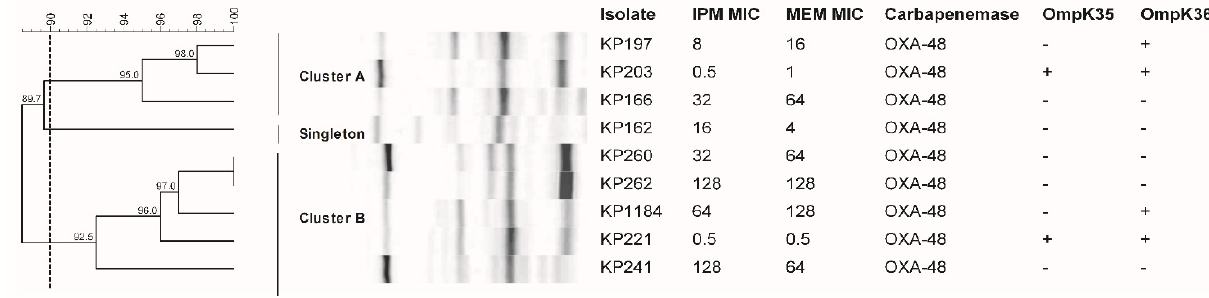
Figure 1. Genetic similarity of OXA-48-producing K. pneumoniae isolates. Dendrogram of genetic similarity based on ERIC-PCR generated by BioNumerics using UPGMA. The genetic similarity between the isolates was 90% (dashed line).